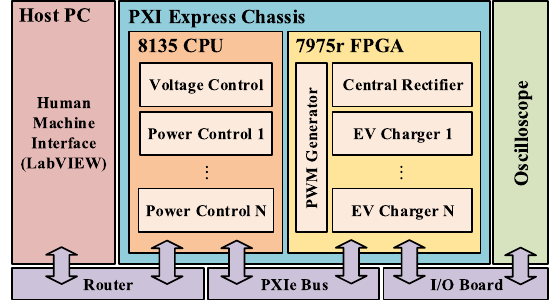
Fig. 2 The architecture of the real-time simulation platform for EV